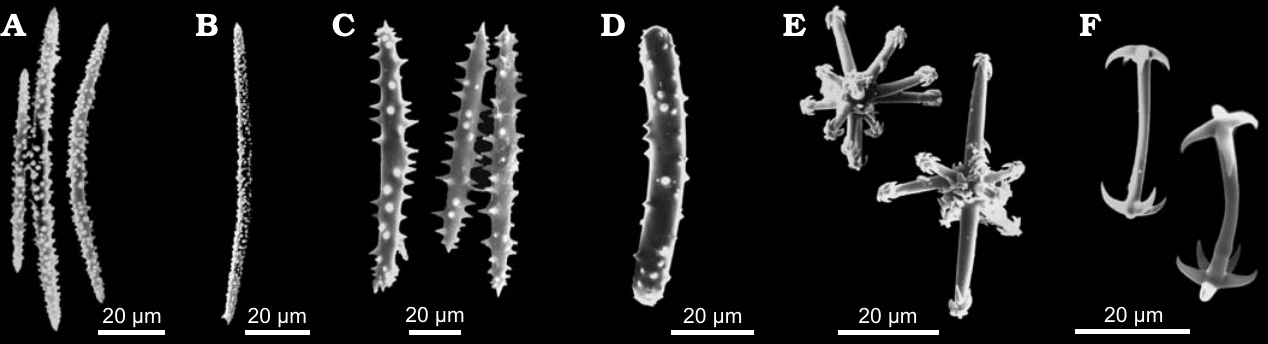
Fig. 3. Morphology of microscleres of Recent freshwater sponges of the order Spongillida. A – C . Microxeas variously ornate by spines or tubercles. A . Spongilla lacustris (Linnaeus, 1759), Palaearctic-Nearctic Region. B . Sterrastrolepis brasiliensis Volkmer-Ribeiro and De Rosa Barbosa, 1978, Neotropical Region. C . Drulia browni (Bowerbank, 1863), Neotropical Region. D . Microstrongyle with spines of Metania reticulata (Bowerbank, 1863), Neotropical Region. E . Aster-like microscleres with hooks of Dosilia plumosa (Carter, 1849), Oriental Region. F . Pseudomicrobirotules of Corvospongilla burmanica (Kirkpatrick, 1908), Oriental Region. SEM images. Modified from Manconi and Pronzato